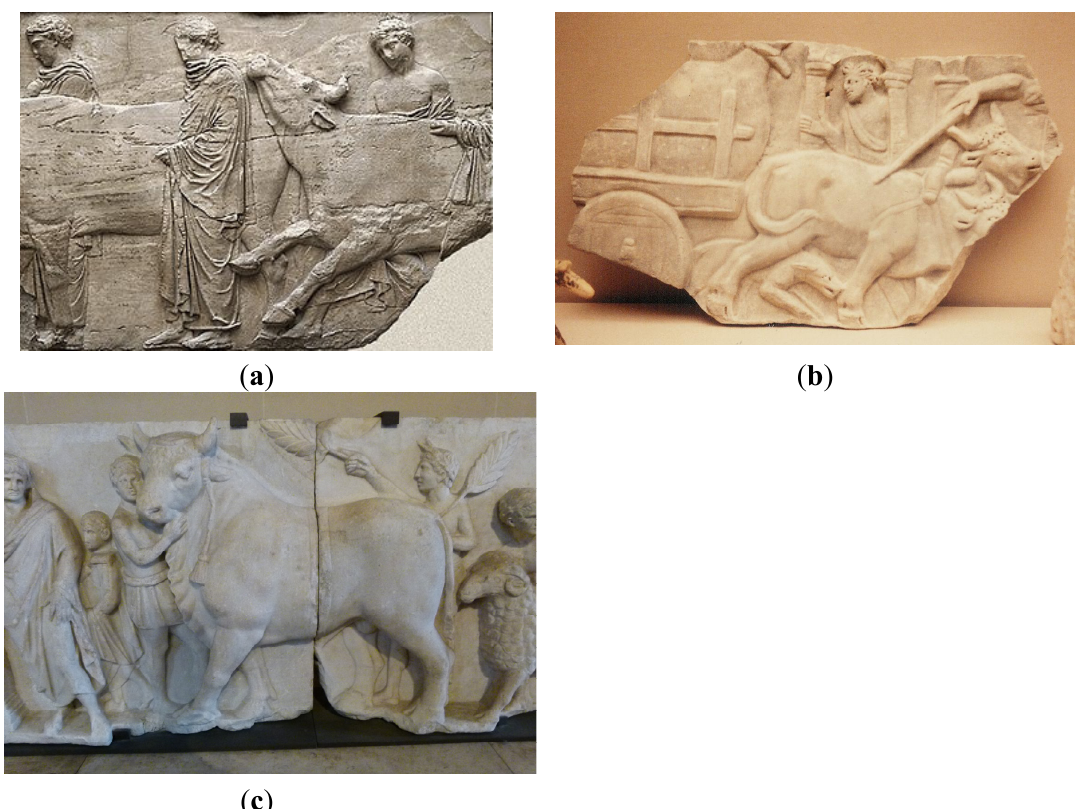
Figure 8. Reliefs showing large Greek or Roman cattle . ( a ) Greek cows, Parthenon frieze, 5th century BC ( b ) Wine transport, Roman, 3th century AD (The British Museum) and ( c ) Roman bull (1 st century, Pompeji, Musée du